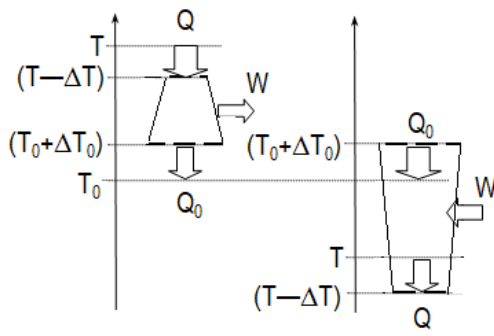
Figure 2. Scheme of the irreversible heat transfer interactions.